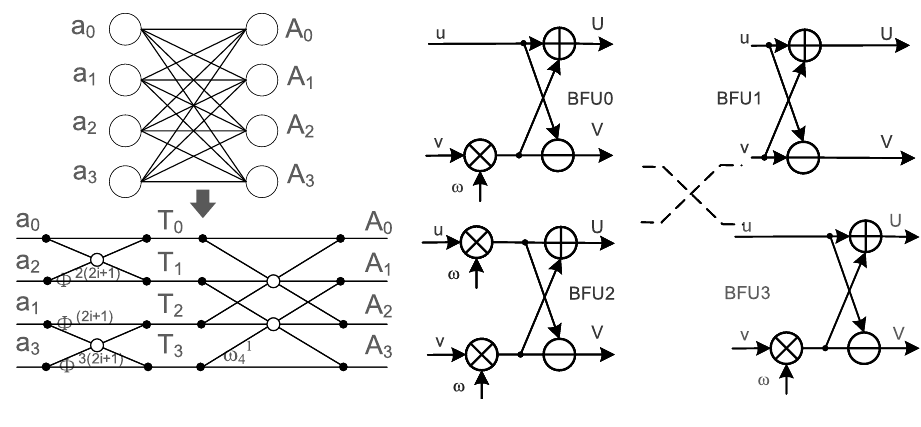
Figure 3: The radix-4 Cookley-Tukey butterfly